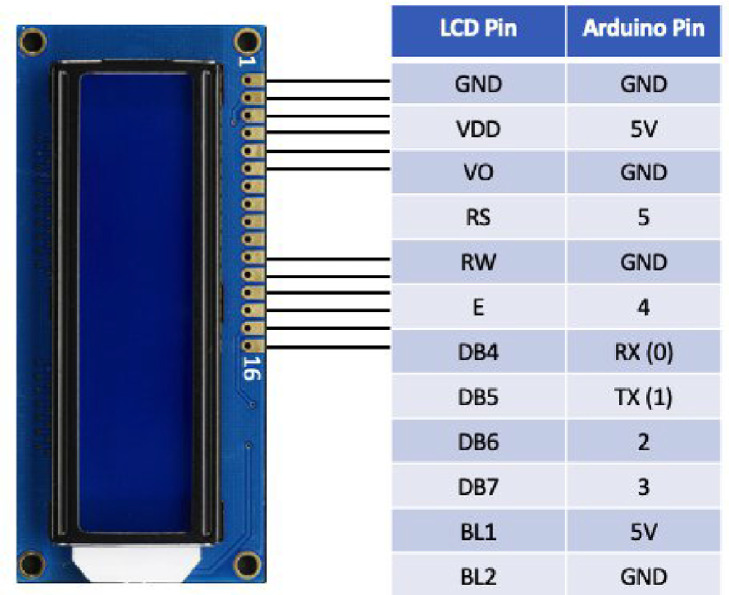
LCD display wiring.